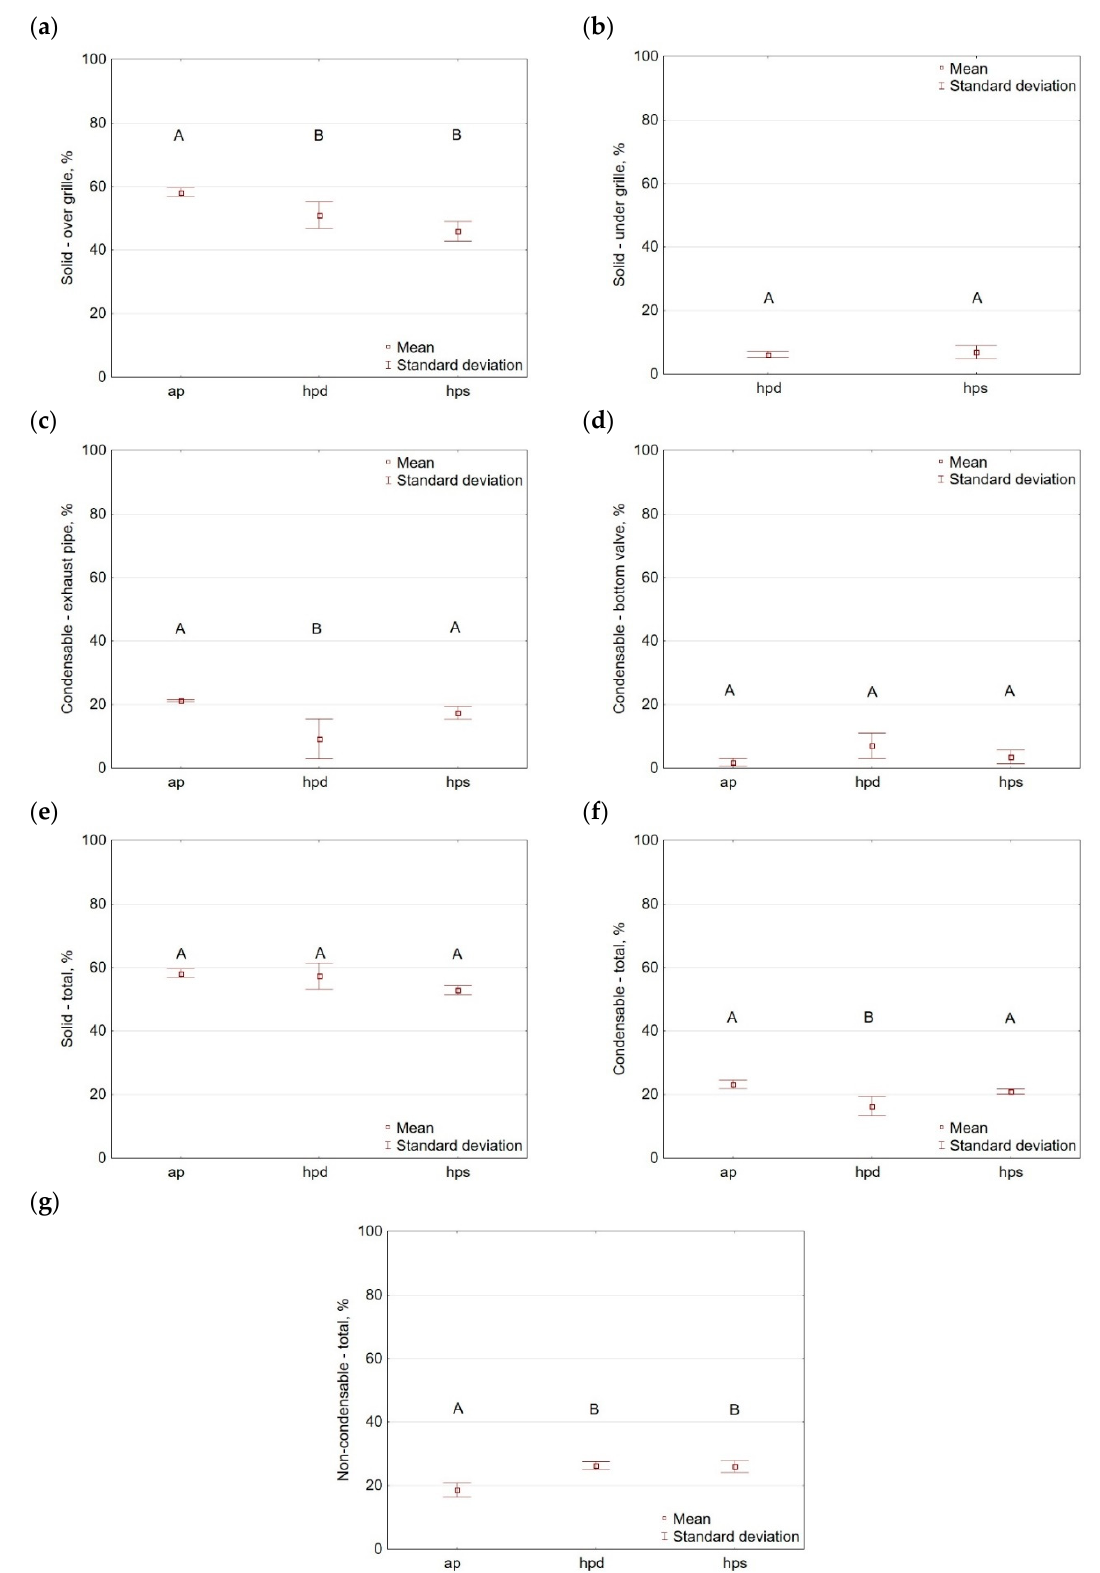
Figure 13. Torrefaction process fractions mass yields, ( a ) mass yield of solid fraction from over grille, ( b ) mass yield of solid fraction from under grille, ( c ) mass yield of condensable fraction from exhaust fraction, ( d ) mass yield of condensable fraction from the bottom valve, ( e ) total mass yield of solid fraction, ( f ) total mass yield of condensable fraction, ( g ) total mass yield of the non-condensable fraction.